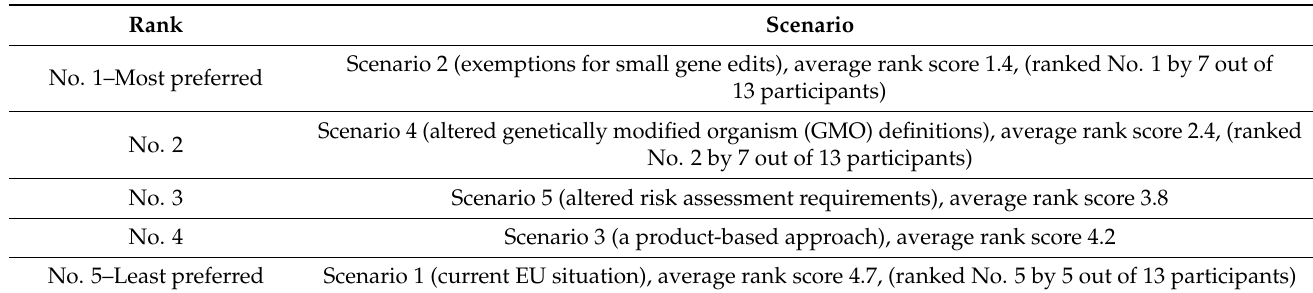
Table 1. Participants’ ranking of potential legislative scenarios.